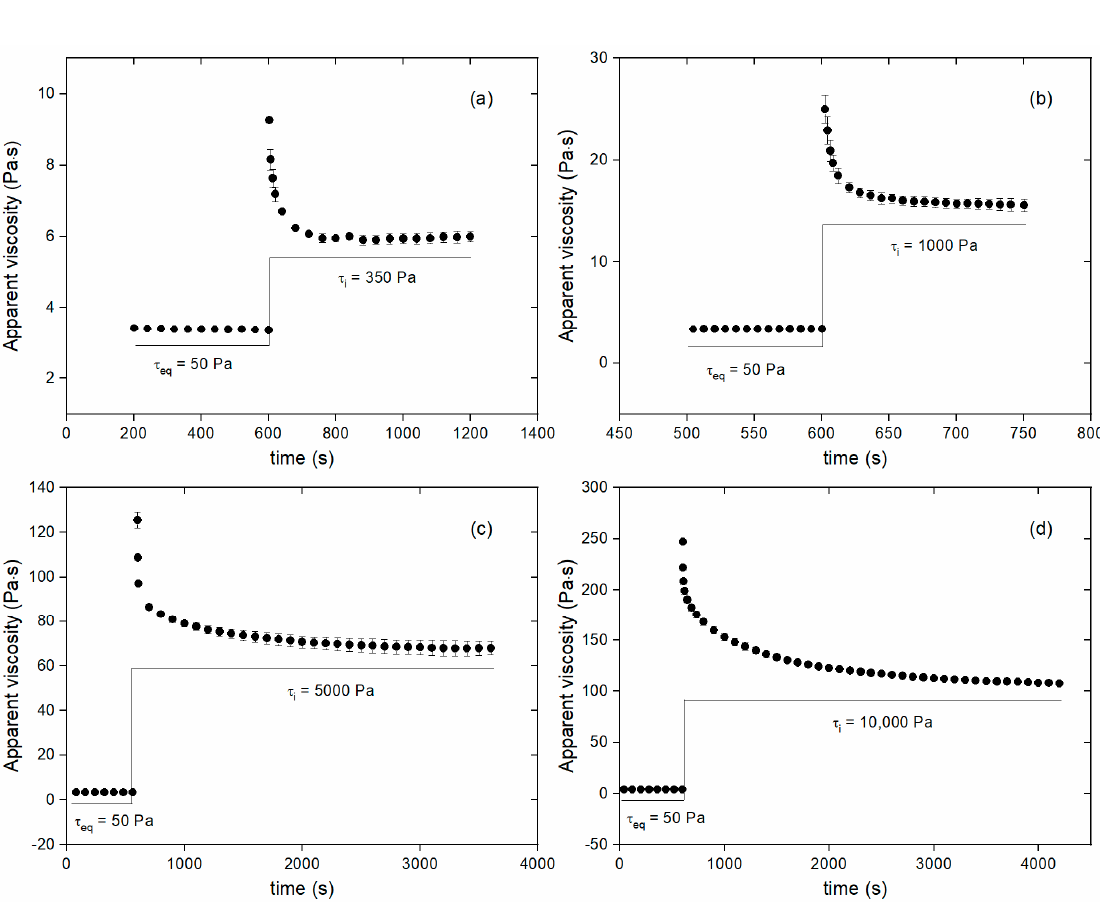
Figure 7. Time response of apparent viscosity to steps-up in shear stress. The initial shear stress corresponds to 50 Pa. ( a ) τ i = 350 Pa; ( b ) τ i = 1000 Pa; ( c ) τ i = 5000 Pa; ( d ) τ i = 10,000